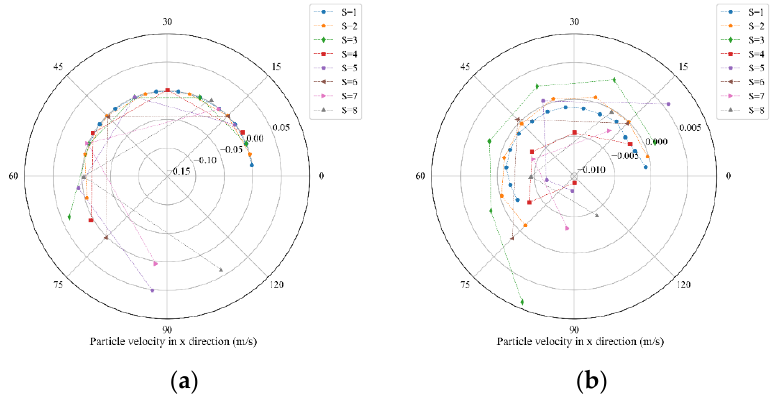
Figure 22. Particle velocity in the X direction. ( a ) Flat surface; ( b ) Convex pattern surface.